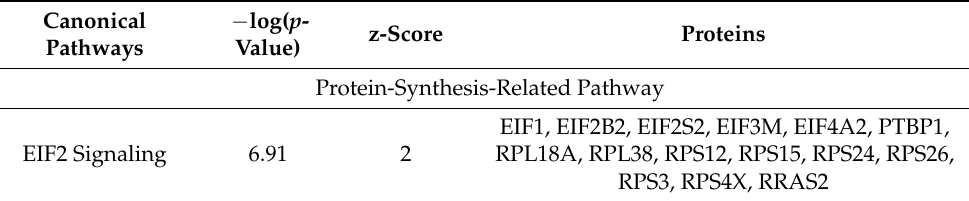
Table 3. Canonical pathways for the 400 µ g/mL of nicotine vs. PBS with positive z-scores.